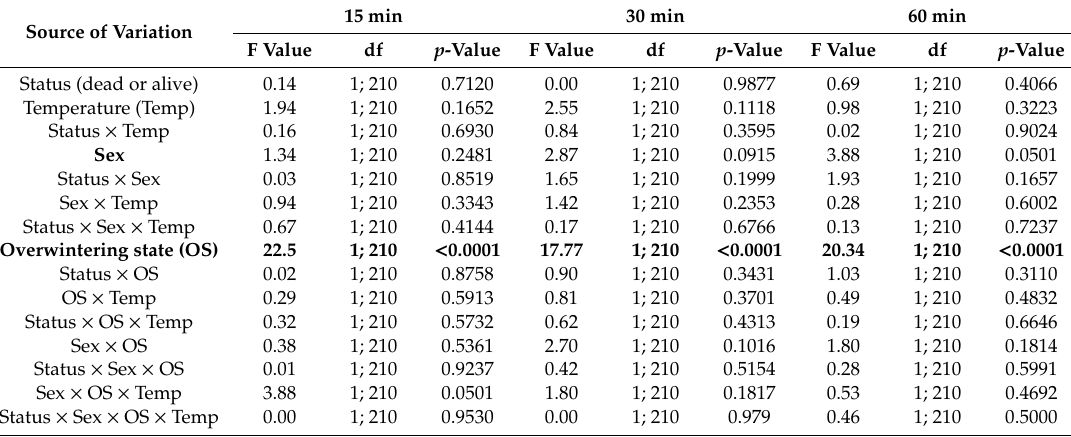
Table 4. E ff ects of Halyomorpha halys nutrient index on tested variables and their interactions. Significant p -values are indicated in bold. The × is used to indicate the interaction between sources of